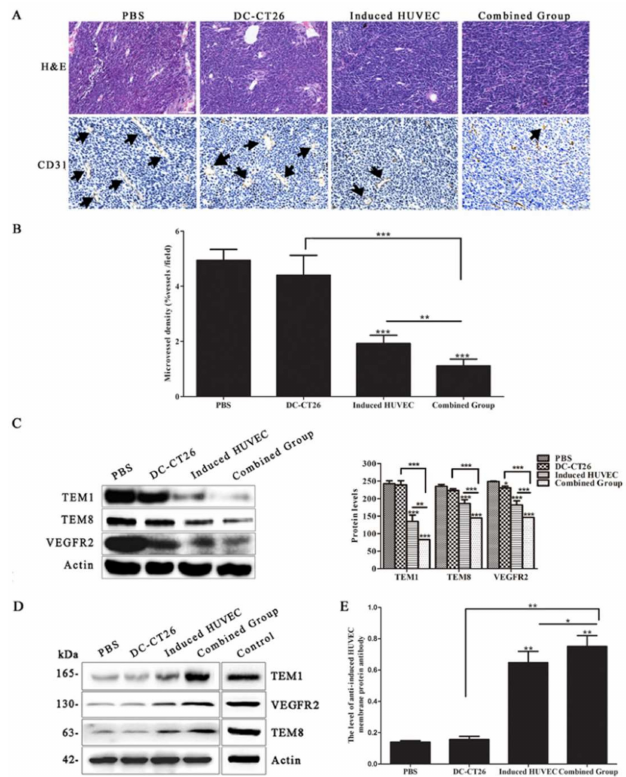
Figure 5. The combined vaccine of DC-CT26 with induced HUVECs exerted better antitumor angiogenesis effects. ( A ) H&E staining and CD31-positive microvessels were tested by immunohistochemical staining; (an arrow represents a CD31-positive microvessel); ( B ) vascular density was counted with CD31-positive staining regions; ( C ) Western blot assay was performed to show the level of the tumor endothelial cell markers TEM1, TEM8, and VEGFR2 in the tumor tissues; ( D ) Western blot assay was performed to show the levels of anti-TEM1, anti-TEM8, and anti-VEGFR2 in mouse serum; ( E ) the level of anti-induced HUVEC membrane protein antibody was checked by ELISA, (* p < 0.05; ** p < 0.01; *** p <